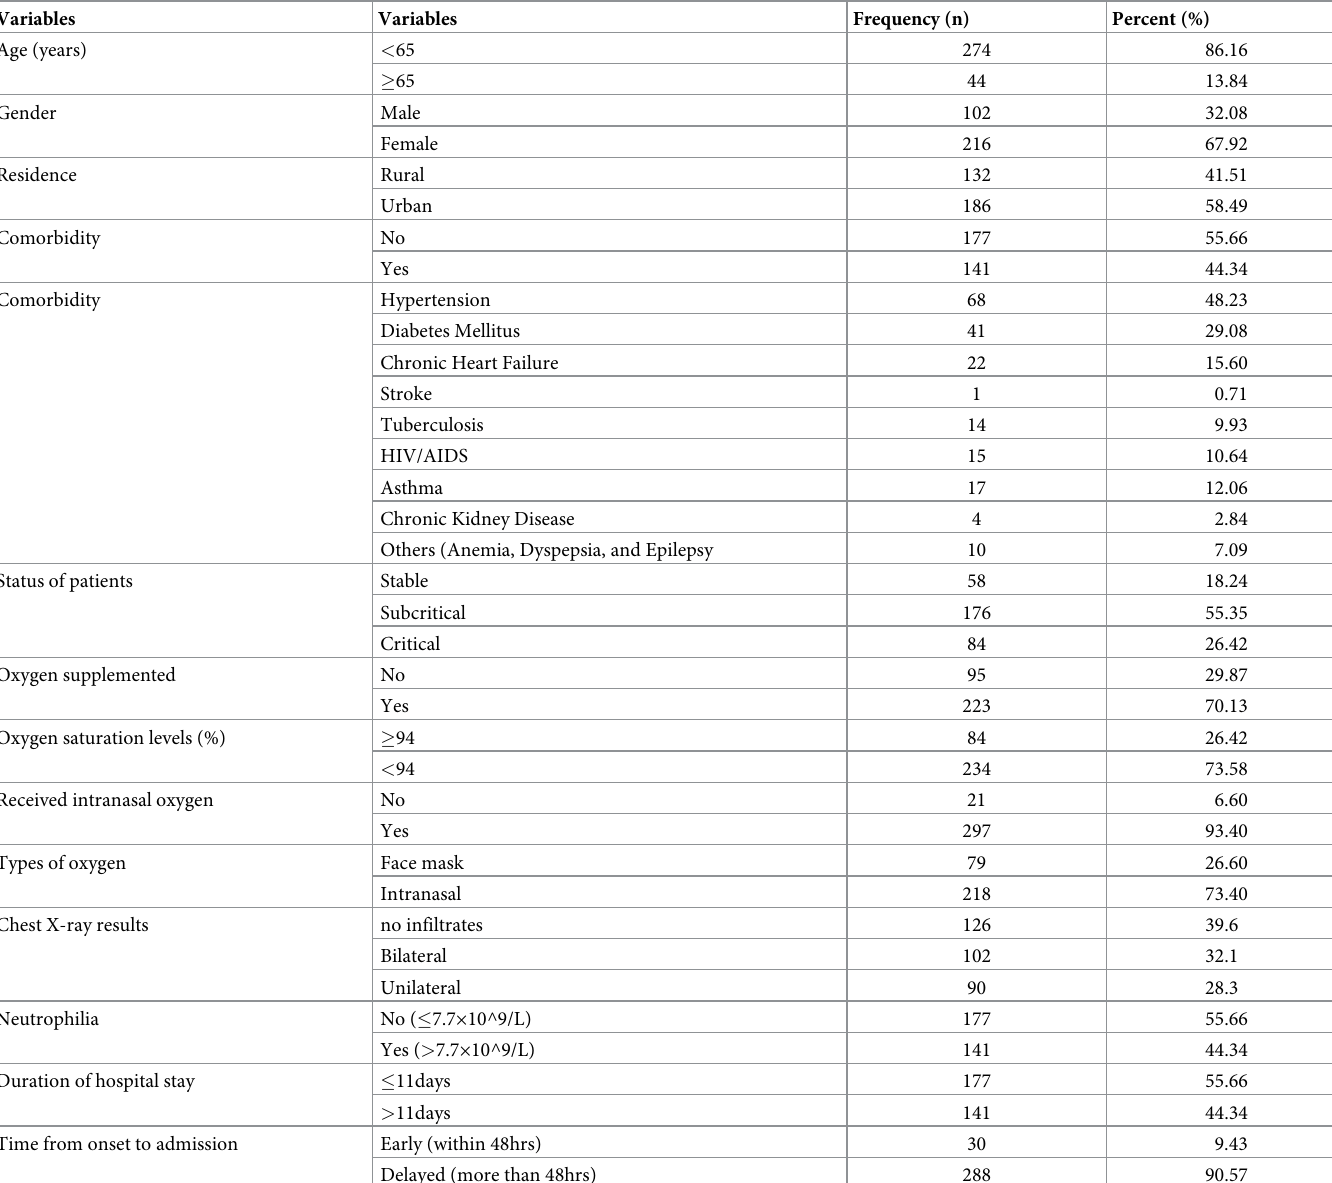
Table 2. Socio-demographic characteristics and findings of patients admitted with severe COVID-19 at WURH, 2021.